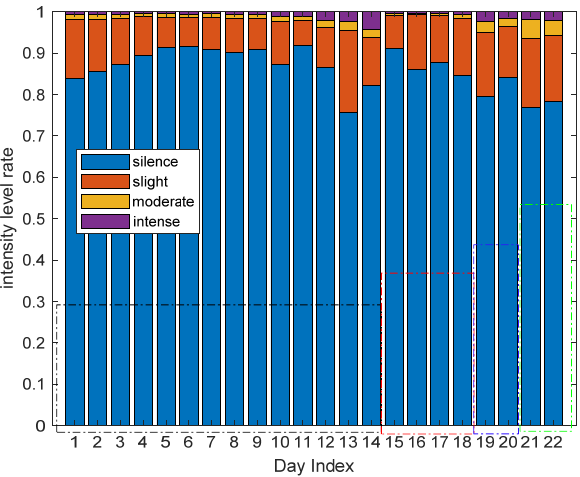
Figure 23. The activity level rate of all the volunteers in all areas.